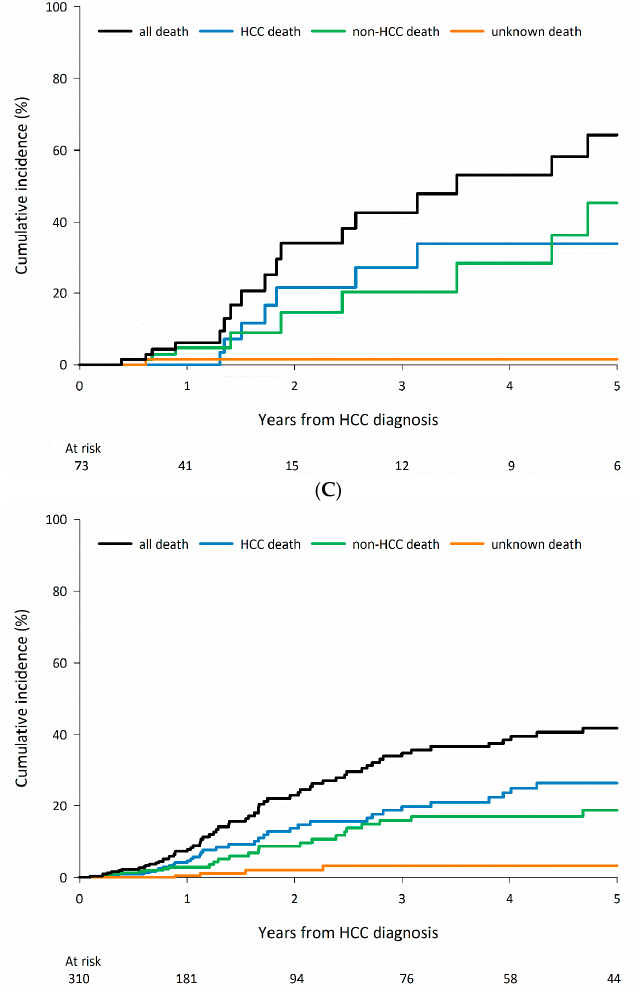
Figure 3. Cumulative mortality risk for hepatocellular carcinoma among patients younger than 75 years who received curative treatments according to chronic liver disease etiology: ( A ) hepatitis C virus; ( B ) hepatitis B virus; ( C ) alcohol use; and ( D ) all negative (defined as no evidence of virus infection or alcohol use).